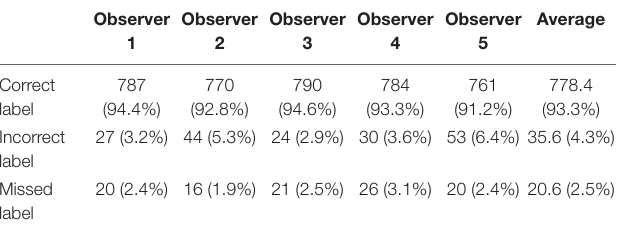
TABLE 4 | Clinical